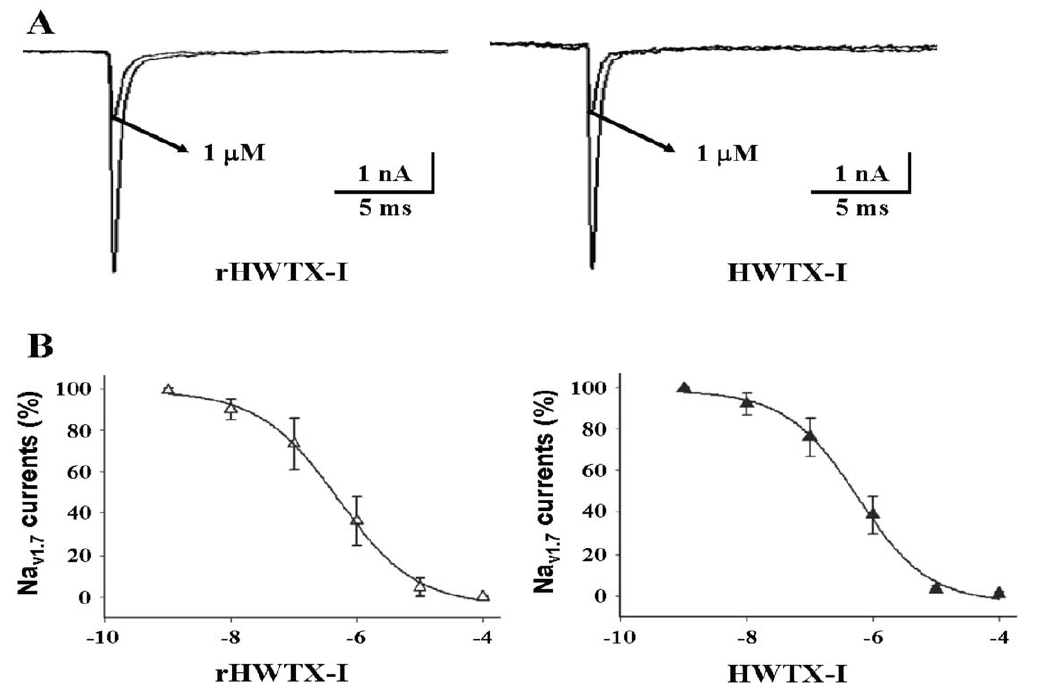
Figure 5. Effects of rHWTX-I and HWTX-I on wild-type hNav 1.7 channels expressed in HEK293 cells. A) Effects of rHWTX-I (left) or native HWTX-I (right) on currents through hNav 1.7 channels that were elicited by depolarization to 2 10 mV from a holding potential of 2 100 mV. The toxin concentration was 1 m mole/L. B) Effects of rHWTX-I (left) or native HWTX-I (right) on dose-response inhibitory curves of hNav 1.7 channels. Data points shown as mean 6 S.E. (each from three to five experimental cells). The IC 50 values of hNav 1.7 in response to rHWTX-I and native HWTX-I were 640 nmole/L and 630 nmole/L, respectively.